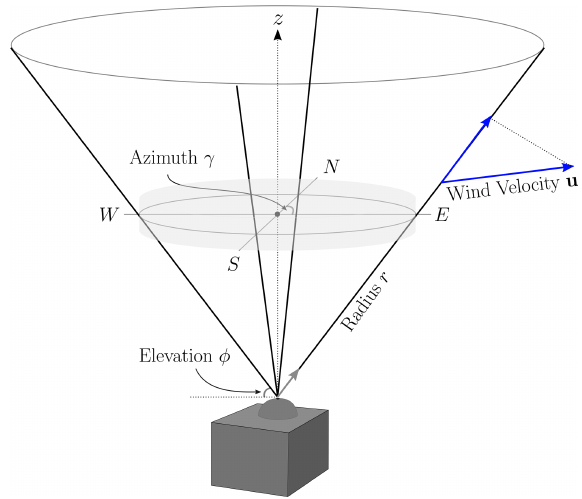
Figure 1. Geometry of a DBS scan performed by a Leosphere WindCube V2 to estimate a vertical profile of the 3D wind velocity. At a frequency of 1Hz, the sampling beam moves through a vertical and four angled positions corresponding to the cardinal directions. The light grey cylinder demarcates a reference volume for the